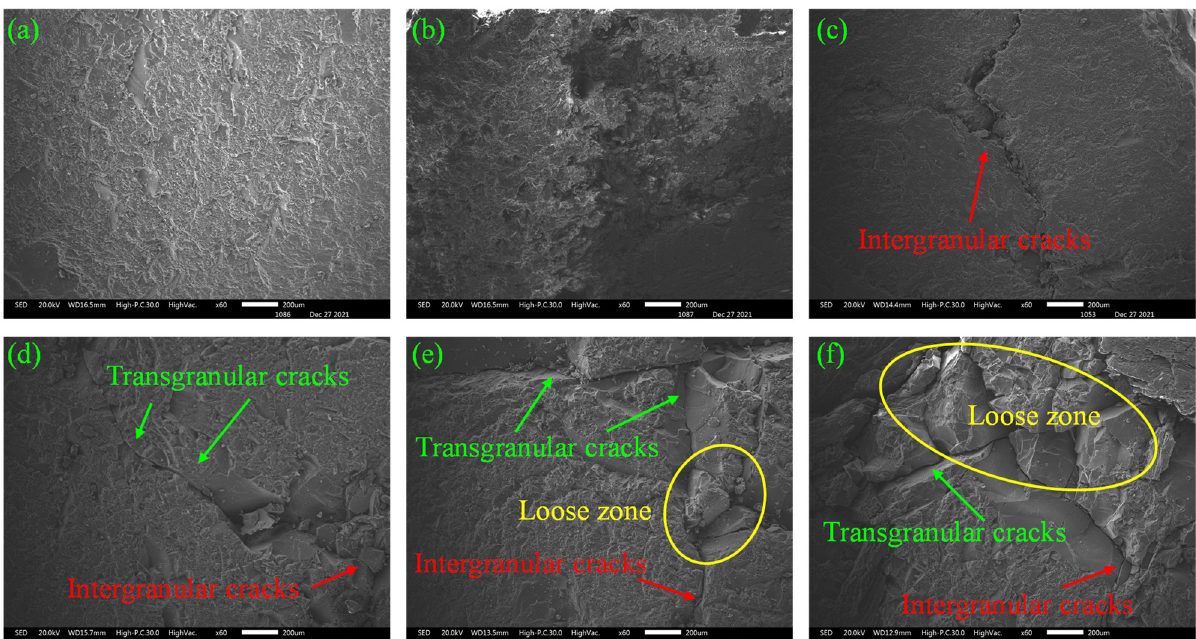
Figure 19. SEM images of specimens at different temperatures. ( a ) 20 °C, ( b ) 200 °C, ( c ) 300 °C, ( d ) 400 °C, ( e ) 500 °C, ( f ) 600 °C.